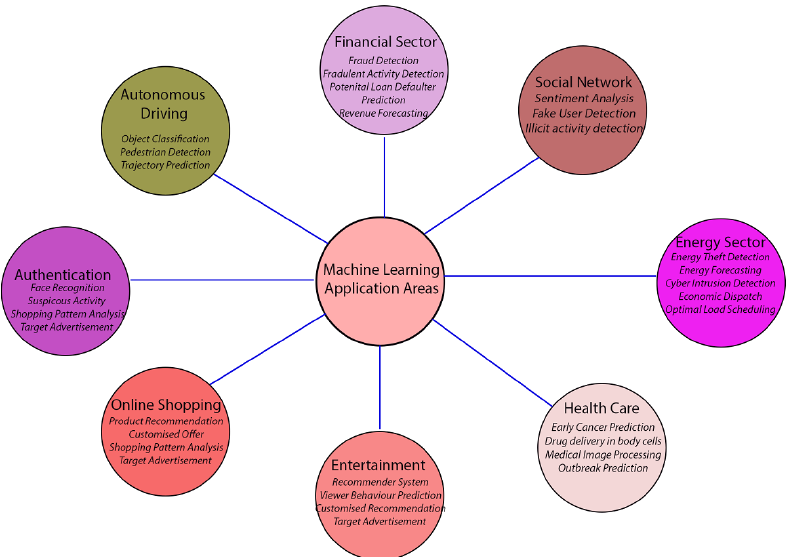
Figure 1. Machine Learning Applications In Different